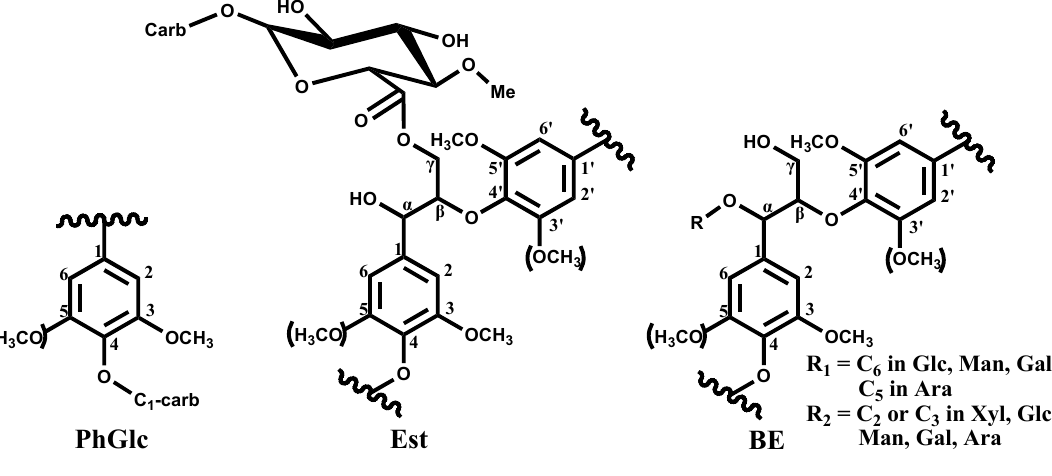
Figure 7. Main lignin-carbohydr ate linkages: PhGlc, phenyl glycoside; Est, γ -ester; and BE, benzyl ether (Reprinted from [48]. Copyright 2012 American Chemical